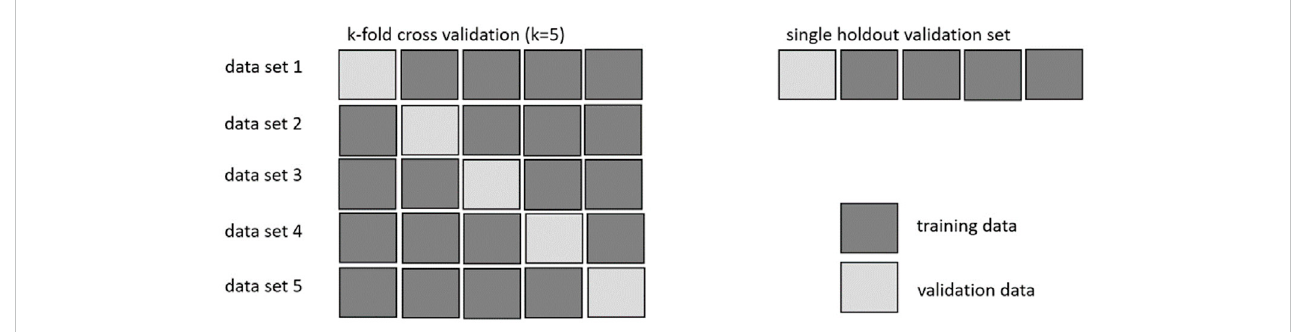
FIGURE 2 k-foldcrossvalidation (left)and single holdoutvalidation (right) aretechniques to randomly select aportion oftraining data to beused asvalidation data.